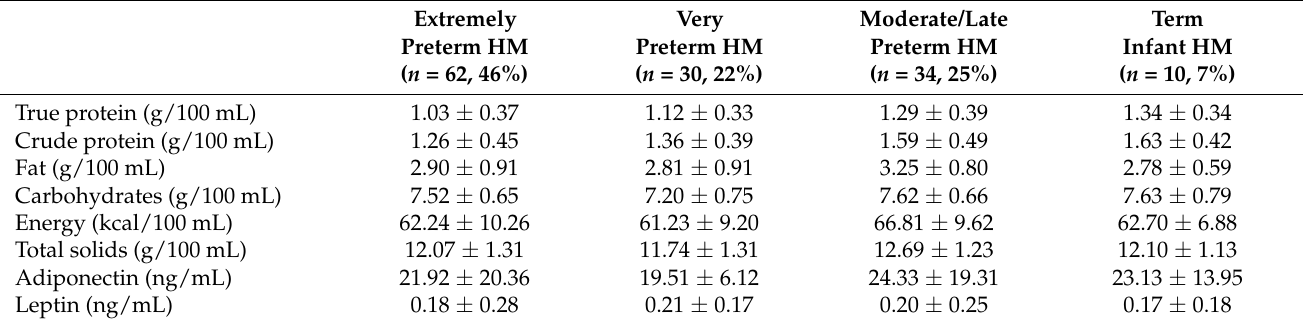
Table 4. Human milk nutrient composition in different